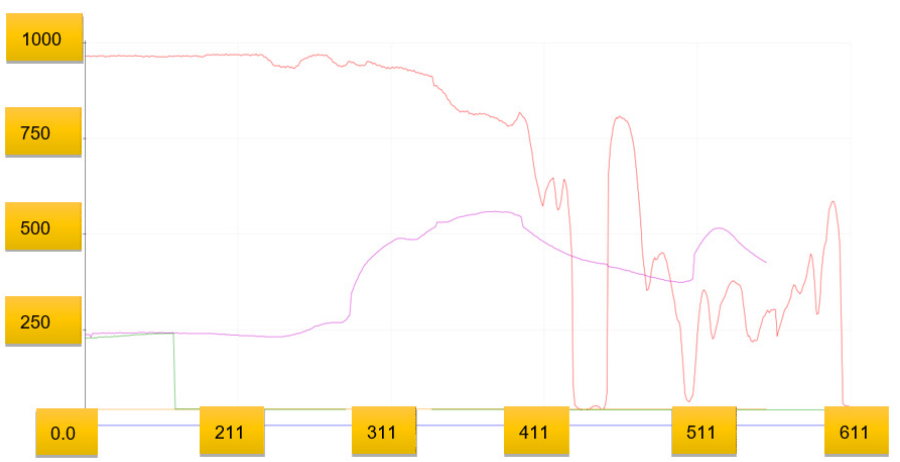
Figure 18. Humidity, Smoke, Temperature, Flame sensor in the absence of